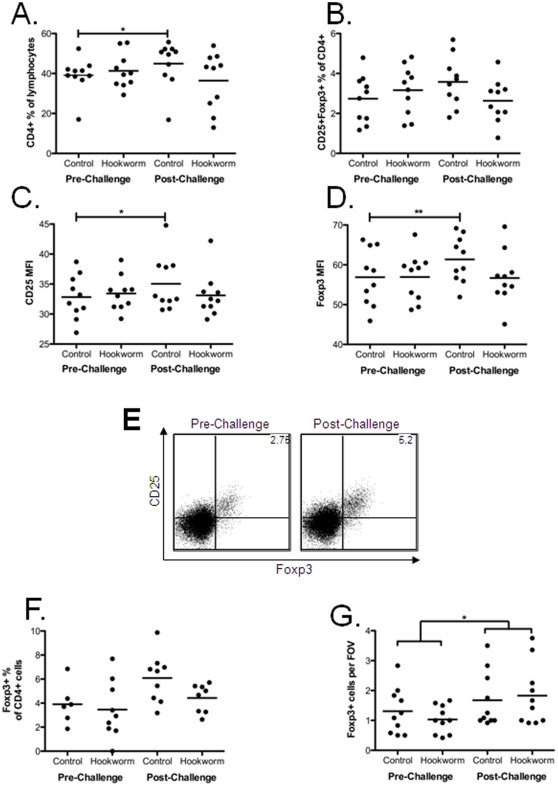
PBMCs from trial 1 pre-challenge (week 20) and post-challenge (week 21) were prepared, cryopreserved and thawed together, then stained for CD4, Foxp3 and CD25.Proportions of CD4+ cells in the PBMC lymphocyte population (A). Proportions of CD25+Foxp3+ cells in CD4+ population (B). CD25 MFI (C) and Foxp3 MFI (D), both in the CD4+CD25+Foxp3+ population. Representative Foxp3 versus CD25 plots of cells gated on CD4+ PBMCs are shown in (E). Cell suspensions were prepared from duodenal biopsies pre-challenge and post-challenge, and stained for CD4 and Foxp3. Foxp3+ proportion of the CD4+ population of biopsy cells (F). Formalin fixed duodenal biopsies were also stained for Foxp3 by immunohistochemistry, Foxp3+ cells per high-power field of view (G). Where paired data was available (all except (F)), data were analysed by two-way ANOVA, and if a significant interaction was found paired t tests were used to show differences within groups. For (F), data were analysed by non-parametric ANOVA. N.S. = not significant, * = p<0.05, ** = p<0.01.